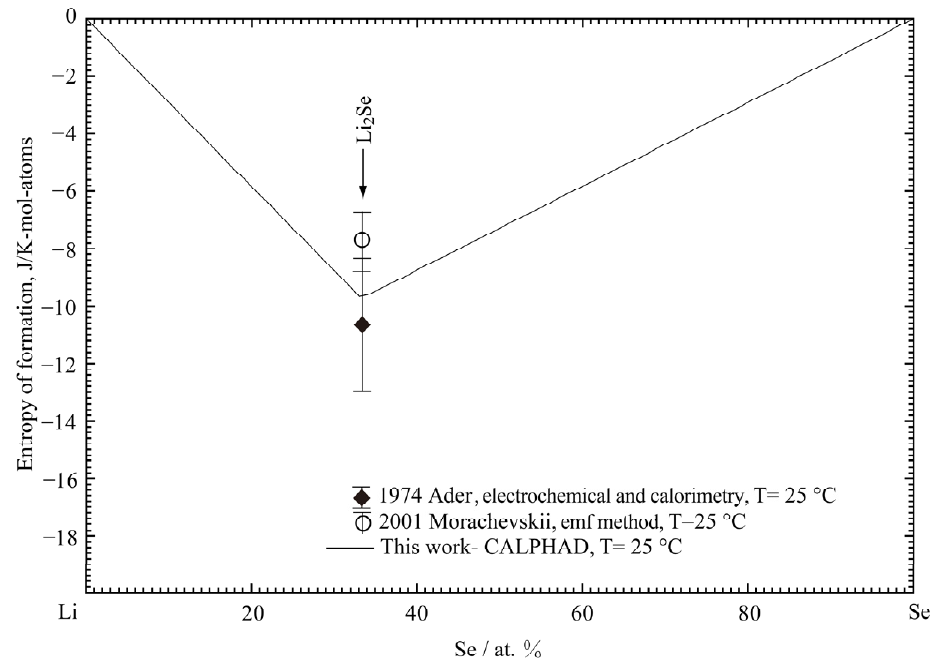
Figure 2. The calculated entropy of formation of the Li-Se binary system at 25 ◦ C compared with the experimental data [35,38].